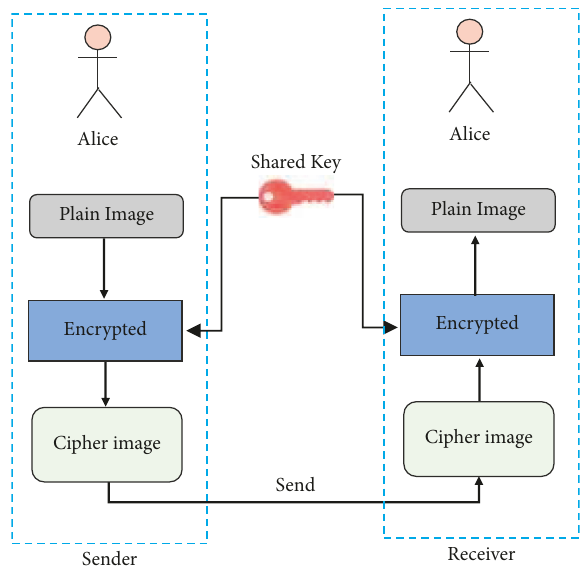
Figure 9: Protocol of encryption in the proposed